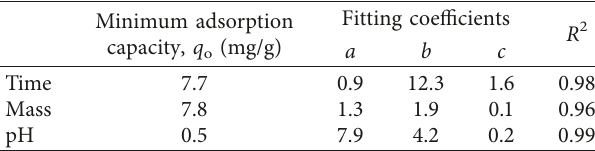
Table 2: Kinetic coefficients in iron 2 extracted